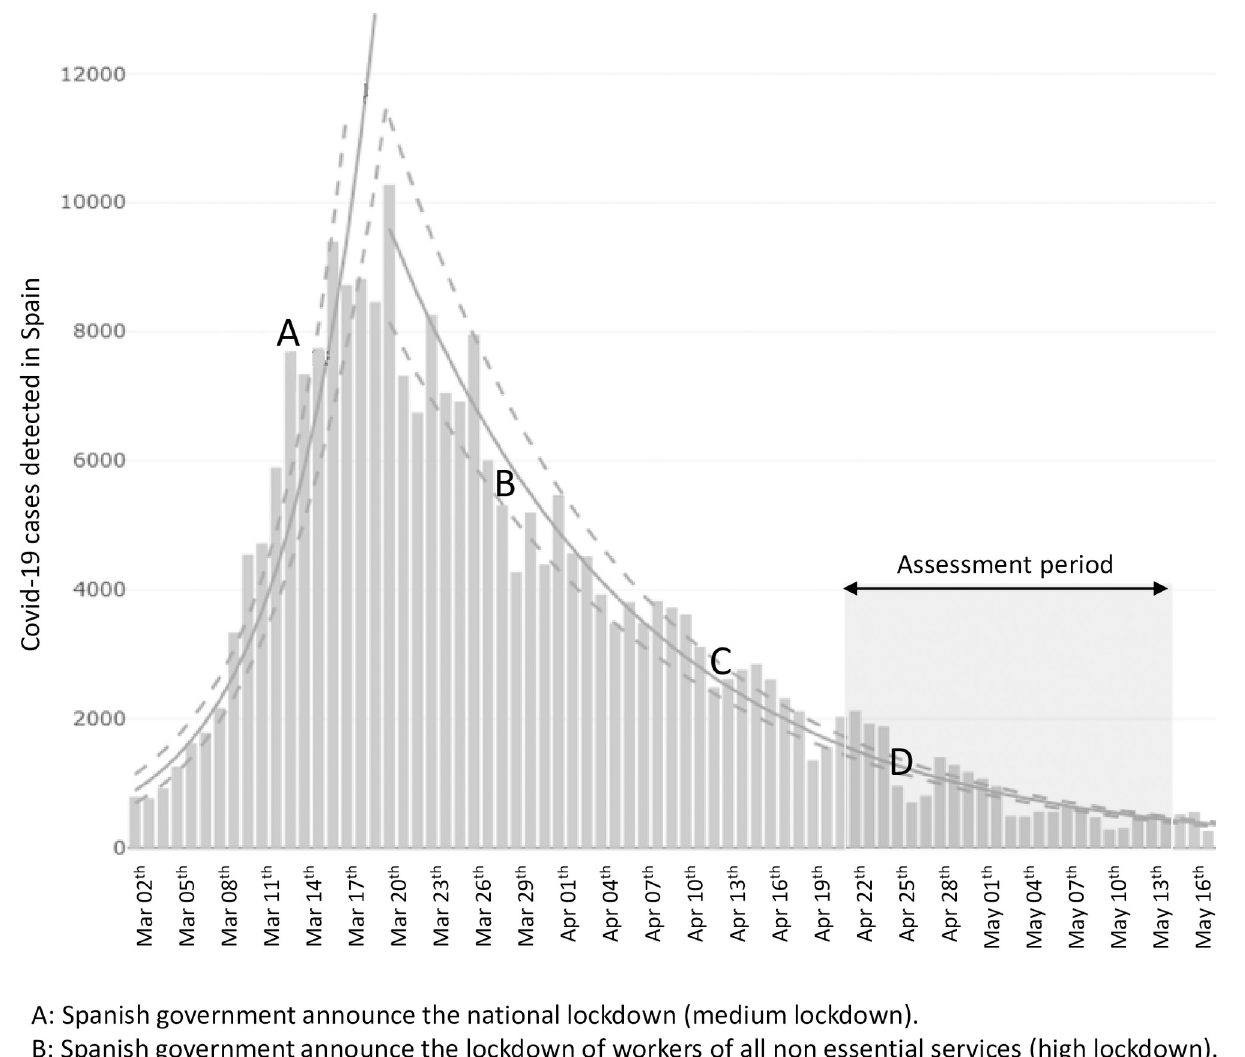
Fig 1. Total daily number of COVID-19 cases detected in Spain during lockdown and the Petrocovid Survey (PS) assessment period.